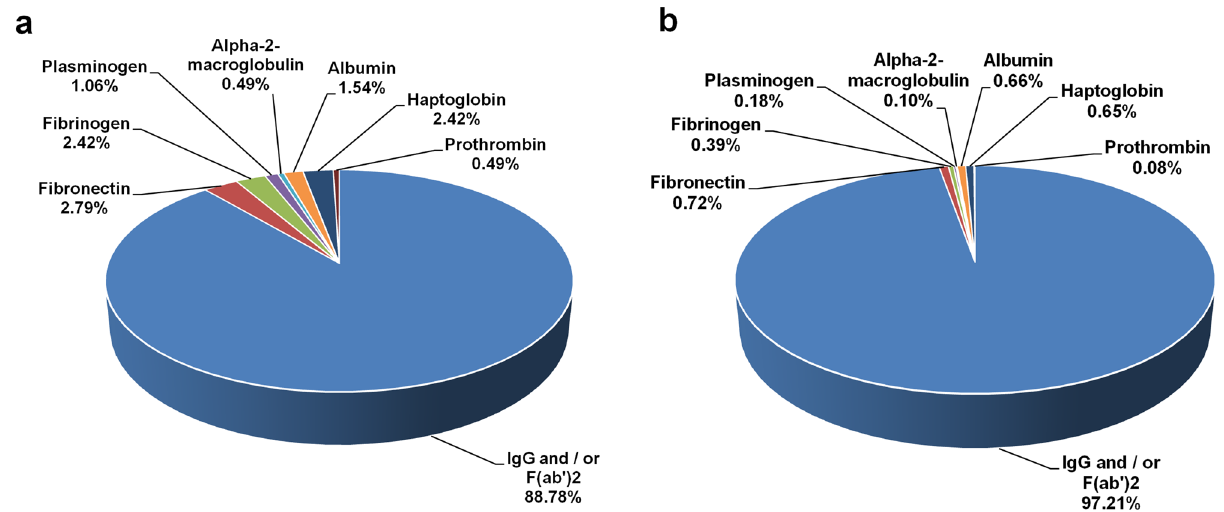
Figure 1. Compositional analysis of two batches of SL PAV determined by LC–MS/MS analysis. ( a ) B1 and ( b )